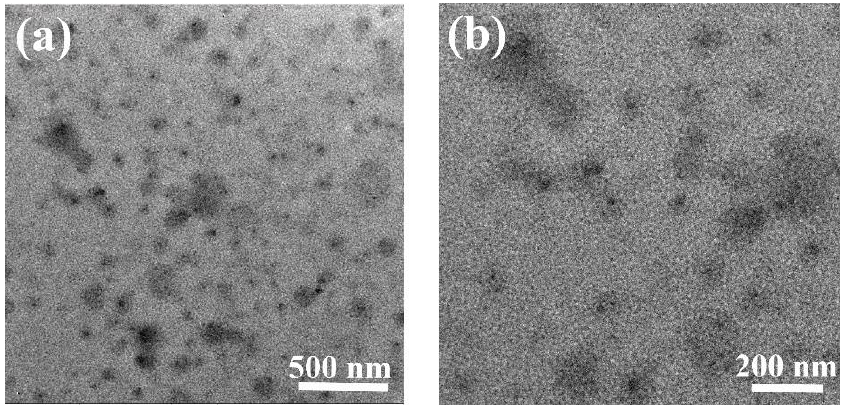
Figure 4. TEM image of micelles in aqueous solution with pH = 2: ( a ) lower magnification and ( b ) higher magnification. ( b ) higher magnification.